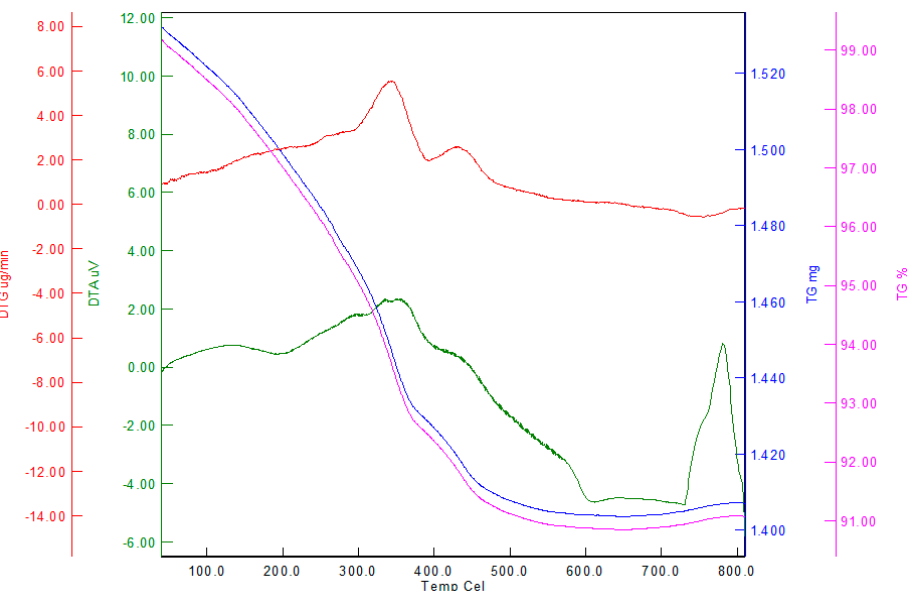
Figure 2. Thermogravimetric and di ff erential thermogravimetric analyses of γ -Fe 2 O 3 / SiO 2 -STZ. Red line: di ff erence thermogravimetry (DTG); green line: di ff erence thermal analysis (DTA); blue line: thermogravimetry analysis (TG) expressed in mg; pink line: TG expressed in wt%.